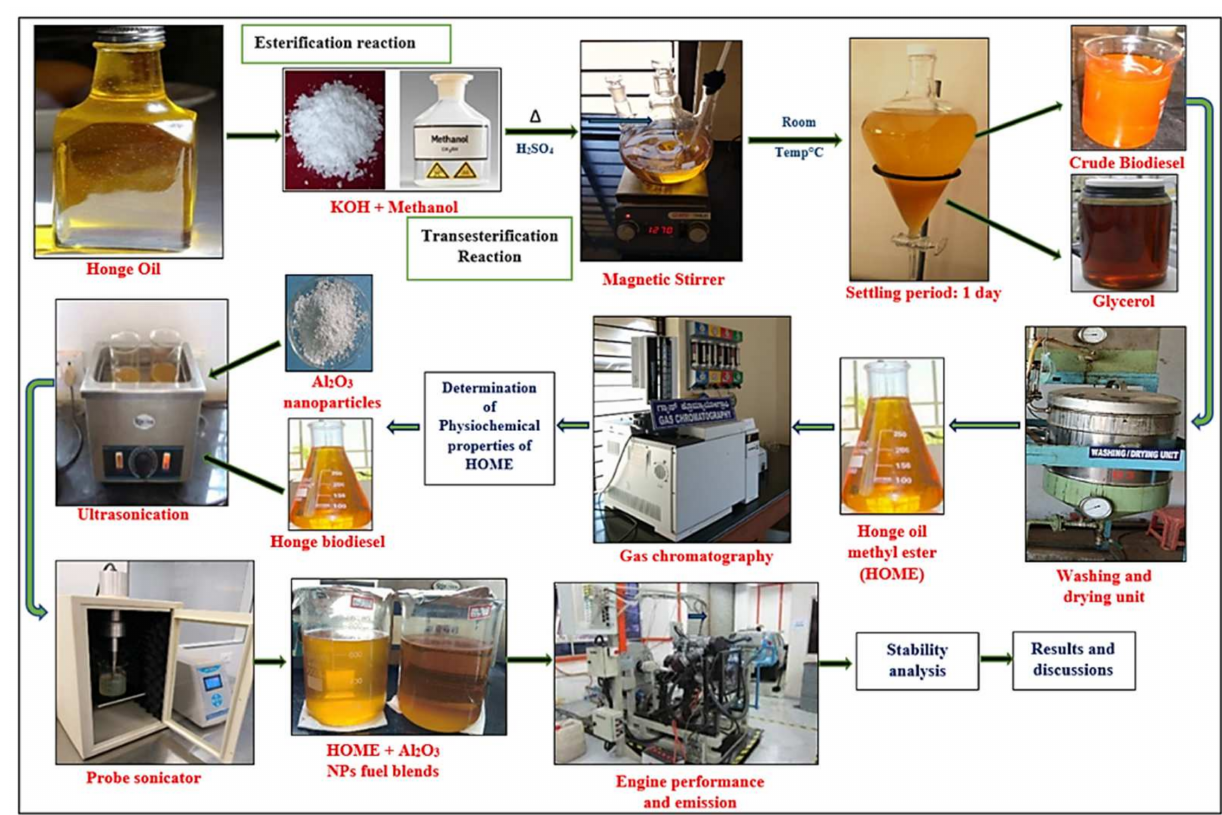
Figure 2. Preparation of honge biodiesel (adapted from Elsevier [50] with permission, License Number 5140860661341). Table 4. The fatty acid profile of honge oil methyl ester (adapted from Elsevier [50] with